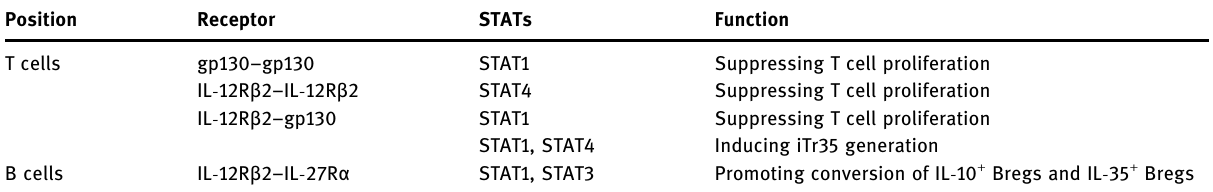
Position Receptor STATs Function